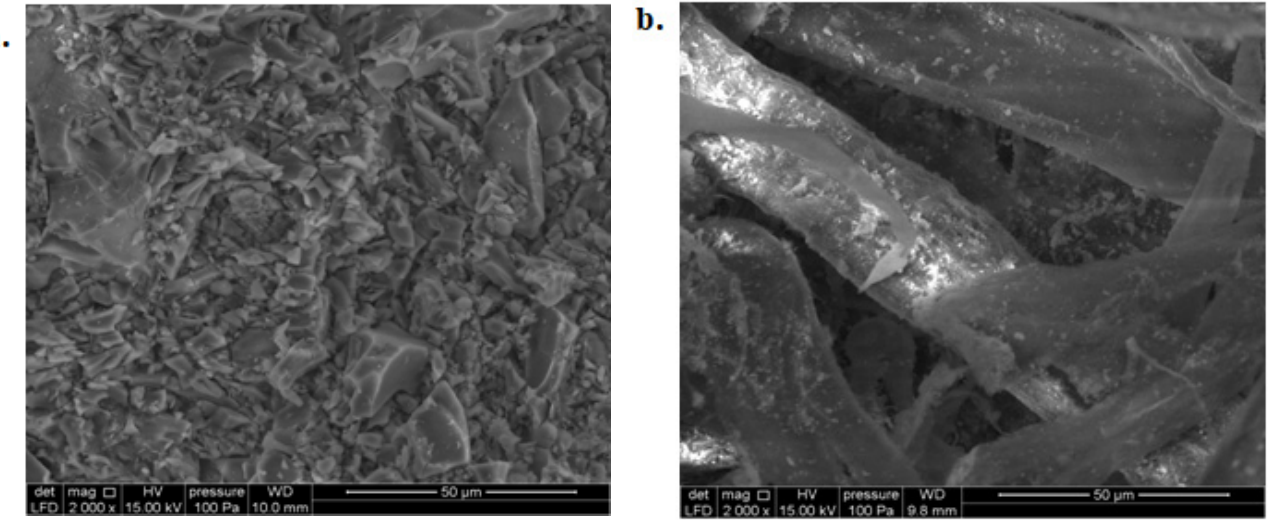
Figure 3. Scanning electron microscopy (2000×) of ( a ). pre-composted waste mixture and; ( b ). final compost.